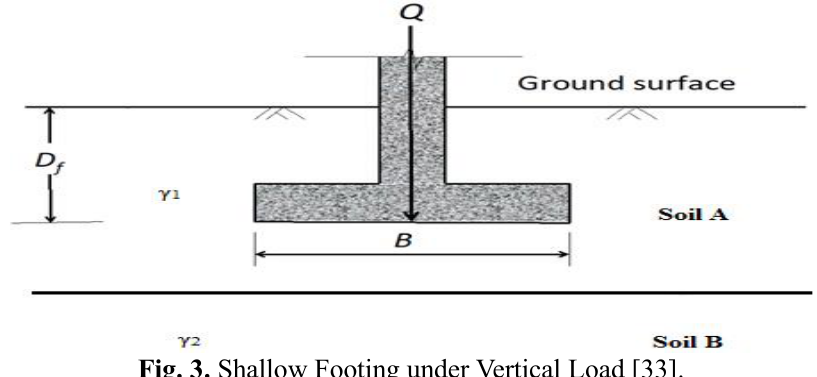
Fig. 3. Shallow Footing under Vertical Load [33].